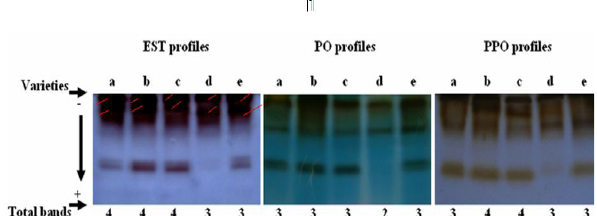
Fig. 2. Different isozyme (EST, PO and PPO) profiles in 5 dif- ferent cultivars of Catharathus roseus (L.) G. Don. Bars distin- guish the closely separated bands Polyphenol oxidase (PPO) Different banding patterns were observed for polyphe- nol oxidase (PPO) isozyme. As a whole a total of six differ- ent bands (PPO 1-PPO 6) with Rm 0.025-0.650, cultivars ‘b’&‘c’ expressed maximum bands (4), on the other hand